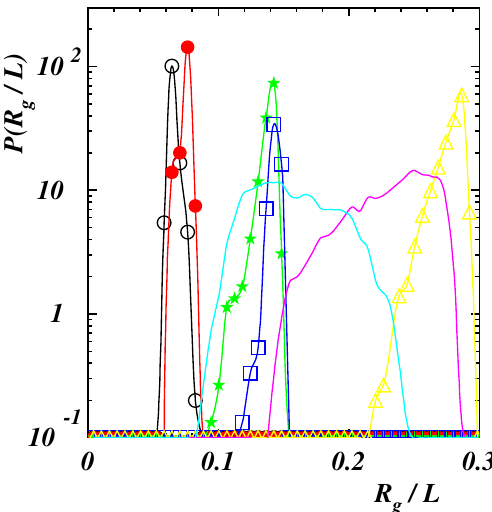
Figure 3. Normalized probability distribution function of the gyration radius R g in absence of the external force for L p / L = 0.1 (black open circles), 0.2 (red filled circles), 0.4 (green filled stars), 0.8 (blue open squares), 2 (yellow open triangles) with (cid:101) / ( k B T ) = 2, and for L p / L = 0.1 (cyan line), 0.4 (purple line) with (cid:101) / ( k B T ) =